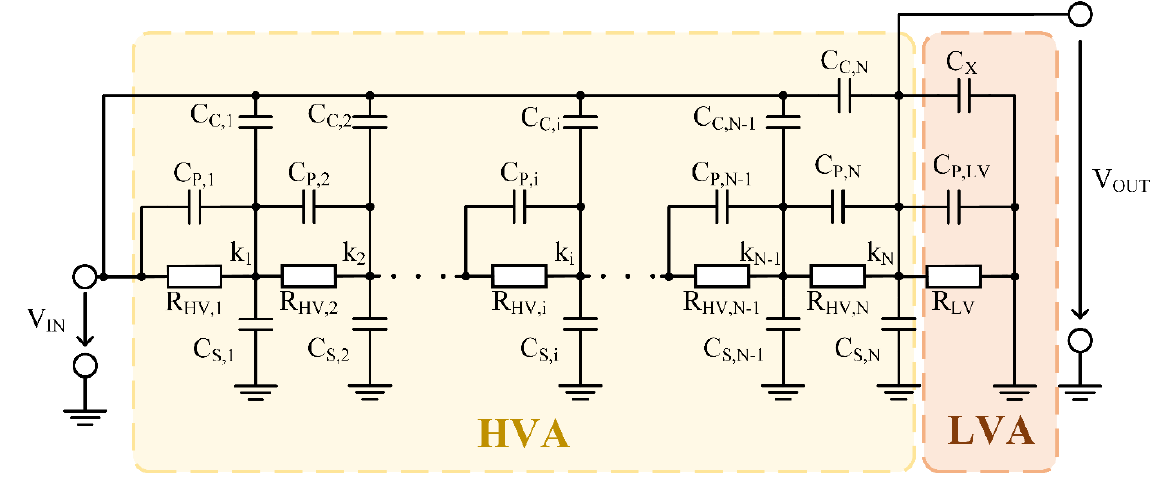
Figure 3. Simplified schematic of the resistive voltage divider with parasitic capacities.